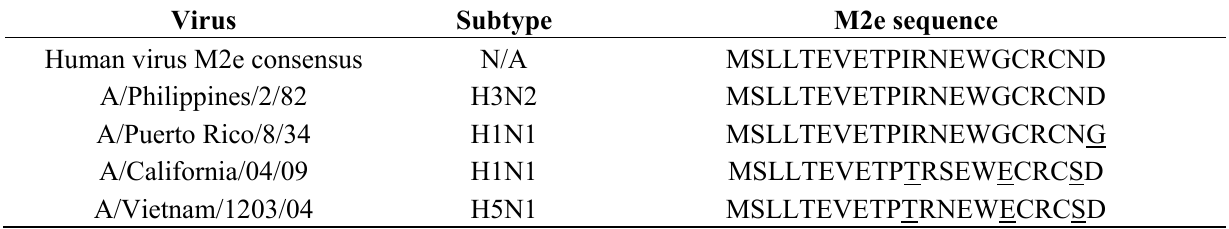
Table 1. Sequence difference of M2e from various influenza viruses.